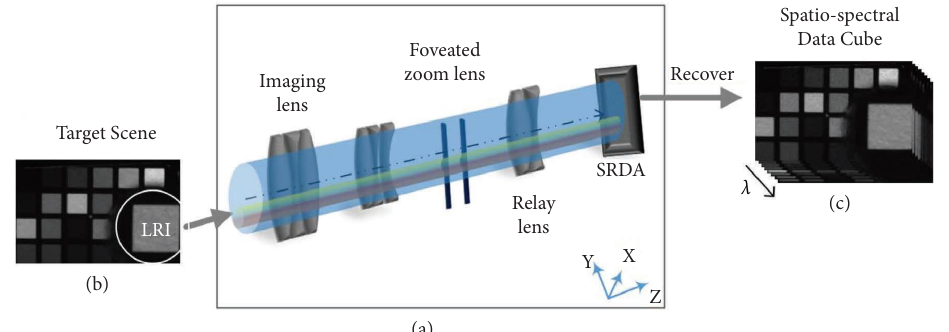
Figure 1: Principle layout of the LSHI. (a) System structure. (b) Target scene. (c) Spatio-spectral data cube of the reconstruction scene.